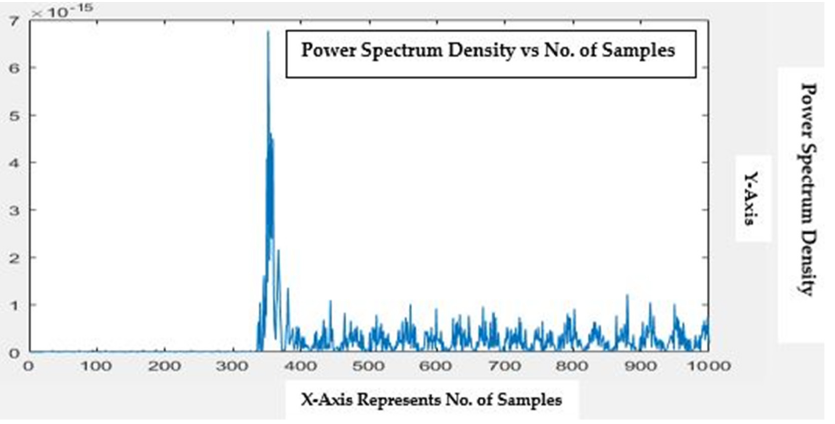
Figure 11. Rotor bar fault in Phase-A: Representation of feature points with 1000 samples (Figures Titled-300 dpi).